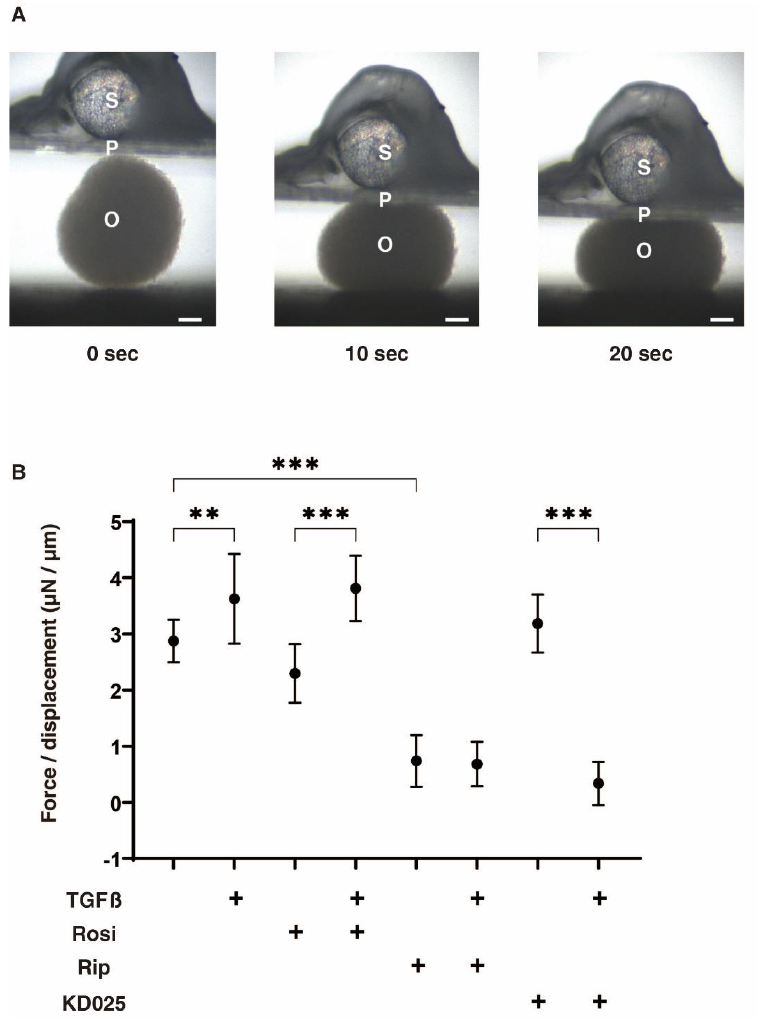
Figure 3. Physical stiffness of 3D HconF organoids in the absence or presence of TGF β 2 and/or rosiglitazone, ripasudil or KD025. The following eight experimental groups included: (1) control for (2), (2) treated with 5 ng/mL TGF- β 2 (TGF β ), (3) treated with 10 µ M rosiglitazone (Rosi); control for (4), (4) treated with TGF β and Rosi, (5) treated with 50 µ M ripasudil (Rip); control for (6), (6) treated with TGF β and Rip, (7) treated with 50 µ M KD025; control for (8) and (8) treated with TGF β and KD025. Physical solidity of their 3D HconF organoids at day 6 were analyzed by a micro-squeezer (panel ( A ), S; pressure sensor, P; pressing plate, O; HconF organoid, scale bar: 100 µ m), and requiring force to 50 % deformity of single organoid during 20 s were plotted in panel ( B ). All experiments were performed using 10 organoids freshly prepared each. ** p < 0.01, *** p < 0.005 (ANOVA followed by a Tukey’s multiple comparison